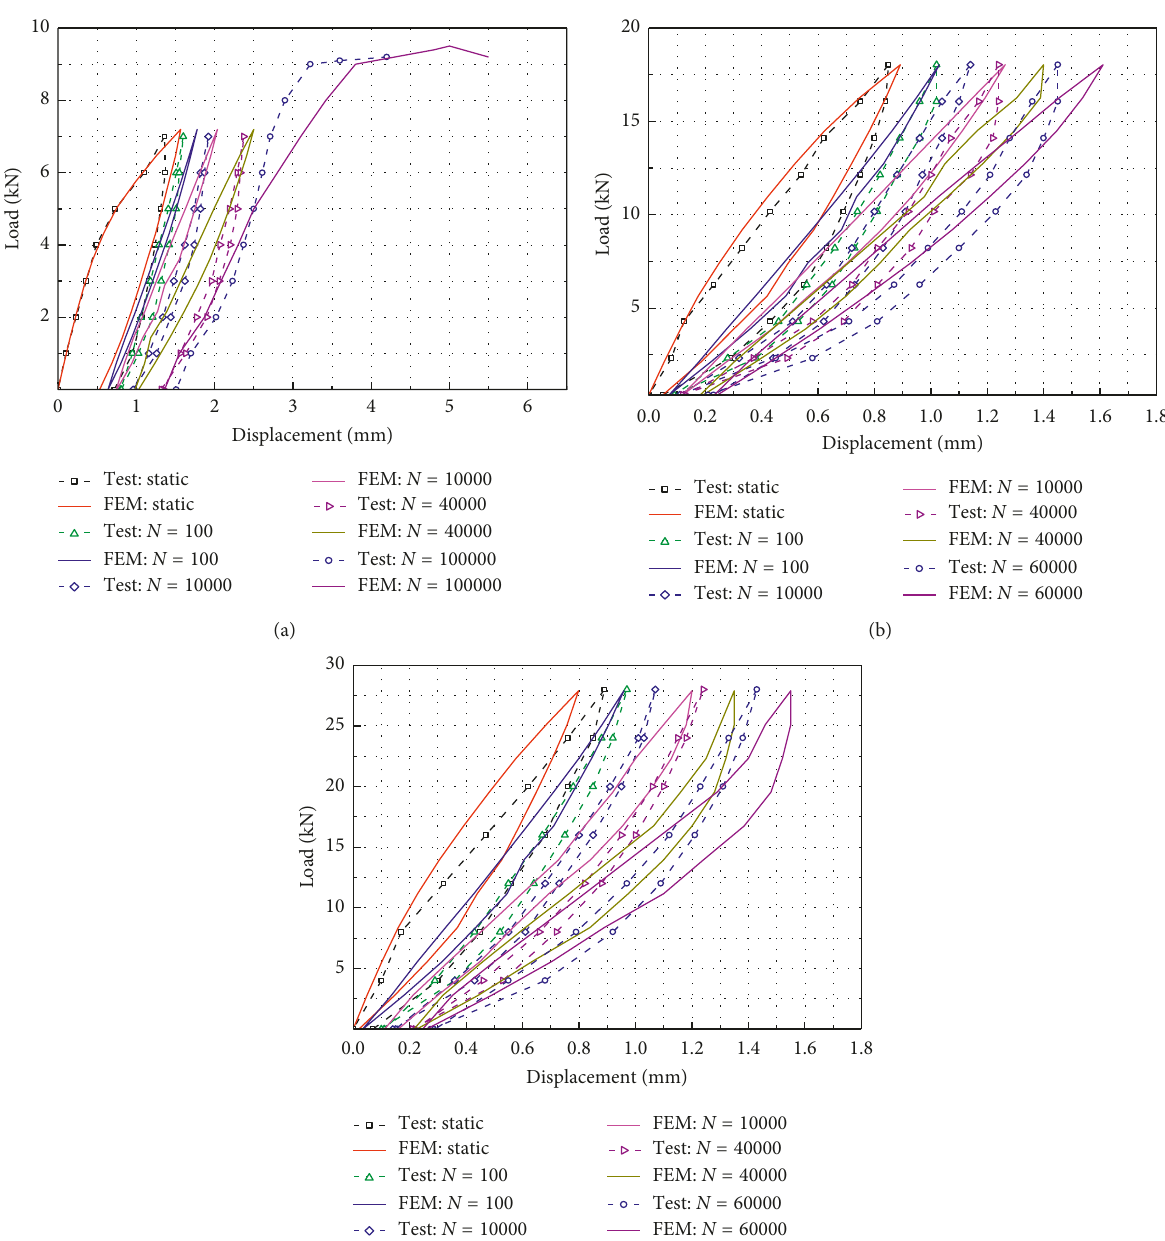
Figure 14: Comparison of FE analysis results and experimental data: (a) D12-F; (b) D20-F; (c)